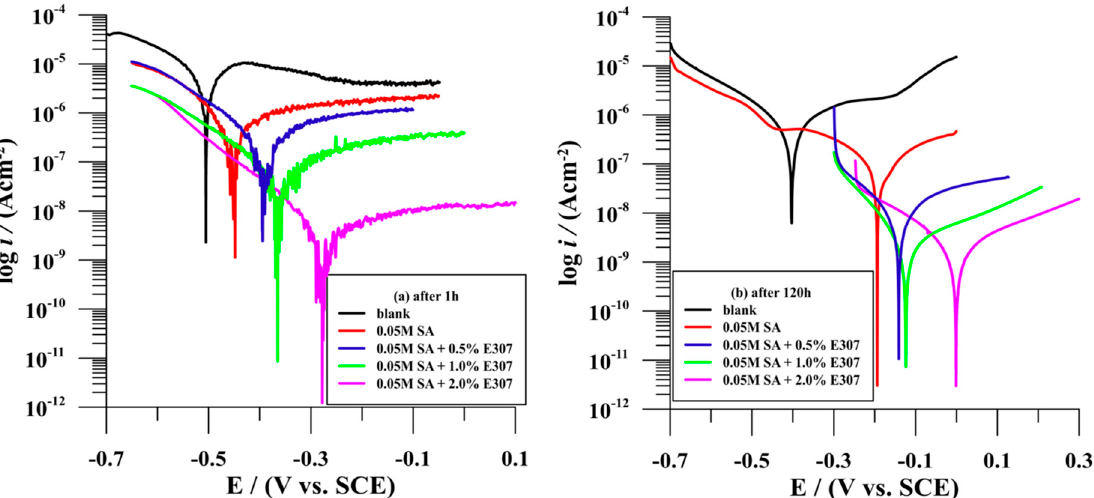
Figure 4. Potentiodynamic polarisation curves (1 mVs − 1 ) for SS type AISI 410S for bare and modified surfaces in a simulated solution of acid rain with pH = 3 at 25 °C. ( a ) After 1 h of immersion. ( b ) After 120 h of testing. (The modified surfaces were prepared by immersion of SS type AISI 410S in 0.05 M stearic acid in ethanol, with and without the addition of E307.) Table 1. Kinetic parameters for corrosion of SS type AISI 410S obtained from potentiodynamic po- larisation curves for the bare and modified surfaces in simulated solution of acid rain with pH = 3 at 25 °C after 1 h of immersion and after 120 h testing.